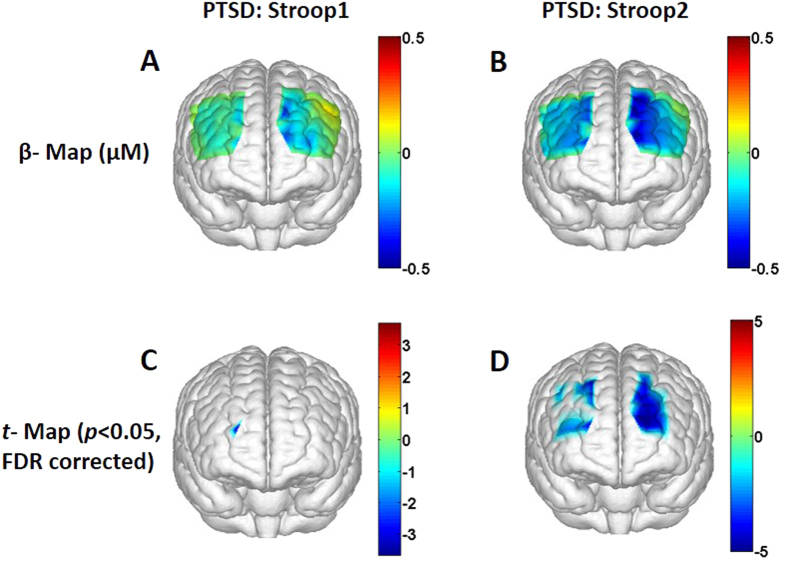
Topographic images of the task-evoked prefrontal activations derived from changes in HbO2 from the PTSD group.(A) Group-averaged prefrontal activation (β-map in μM) evoked by Stroop1 tasks; (B) Group-averaged β-map (in μM) evoked by Stroop2 tasks. (C) A t-statistical map (t-map) that shows significant activations and/or deactivations (one sample t-test, p < 0.05; FDR corrected) on the brain template during Stroop1 tasks. (D) A t-map showing significant activations and/or deactivations evoked by Stroop2 tasks.